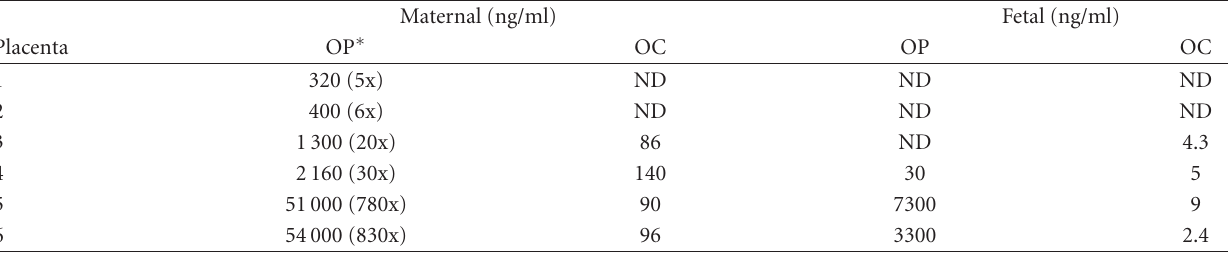
Table 1: Mean maternal and fetal concentrations of oseltamivir phosphate and oseltamivir carboxylate from 6 term placental cotyledons perfused with supratherapeutic concentrations of oseltamivir